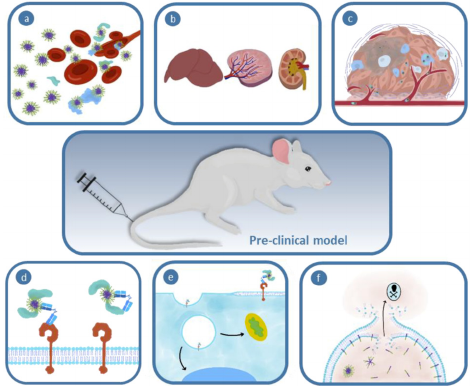
Figure 1. Schematic of the major biological barriers encountered during intravenous treatment in- cluding ( a ) interactions with blood components; ( b ) mononuclear phagocytic system organ clear- ance; ( c ) tumor barriers (i.e., tumor extracellular matrix); ( d ) biochemical barriers; ( e , f ) cellular barriers including cell membrane, interaction with cellular receptor, intracellular sorting and se- questration in the endosomal compartment. Figure adapted from Simpson et al. [43].